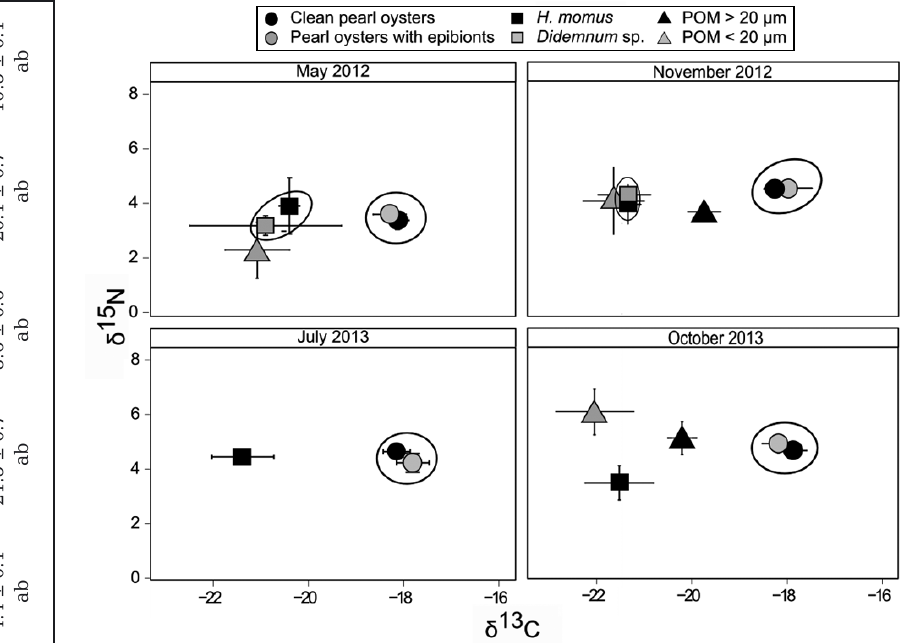
Fig. 3. Mean (±SD) δ 15 N and δ 13 C of pearl oysters, ascidians, and their poten- tial food sources in Mangareva. Particulate organic matter (POM): n = 3; pearl oysters Pinctada margaritifera : n = 5; ascidians Herdmania momus and Didemnum sp.: n = 3. The circles surround groups with the same stable isotope ratios ( δ 15 N and δ 13 C, p > 0.05)